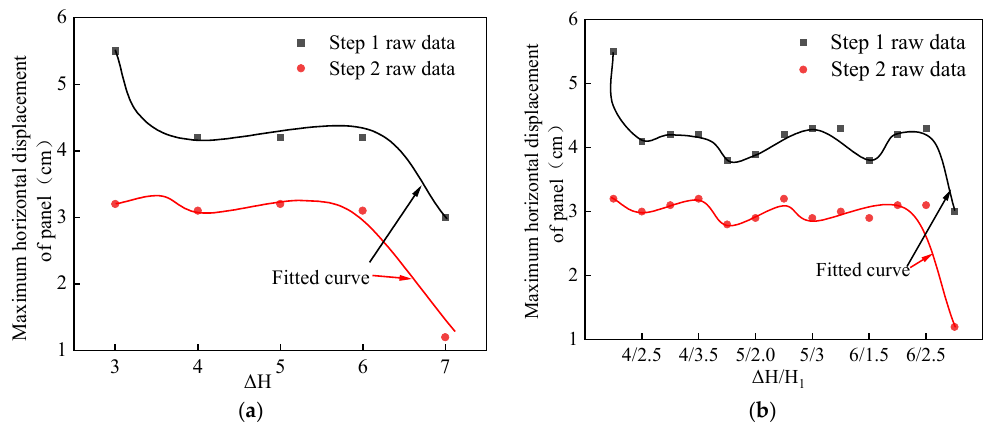
Figure 18. Fitting curve: ( a ) fitting of Formula (13) to the original data; ( b ) fitting of Formula (14) to the original data.